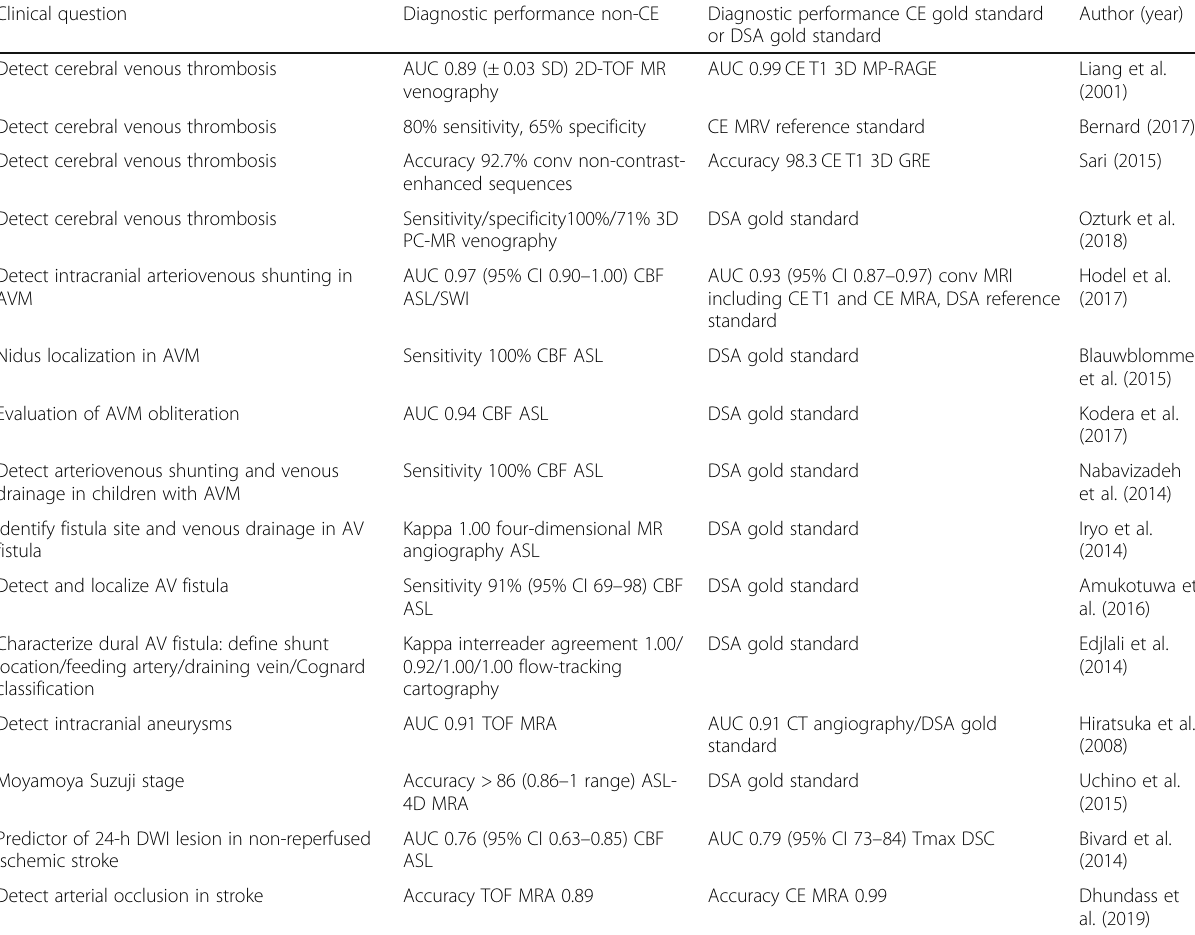
Table 1 Diagnostic accuracy measures in non-contrast-enhanced MRI techniques and contrast-enhanced techniques in cerebrovascular disease Clinical